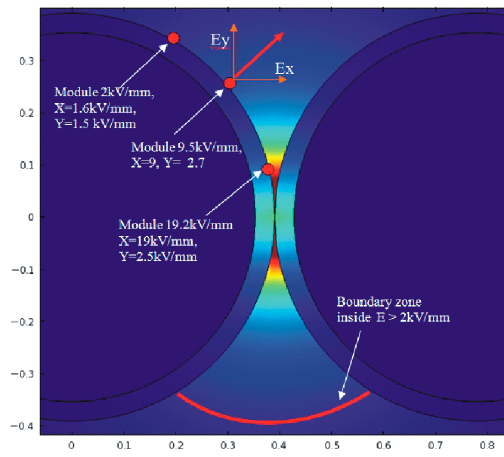
Figure 12. The 2D electric field strength distribution for two parallel wires with direct contact.